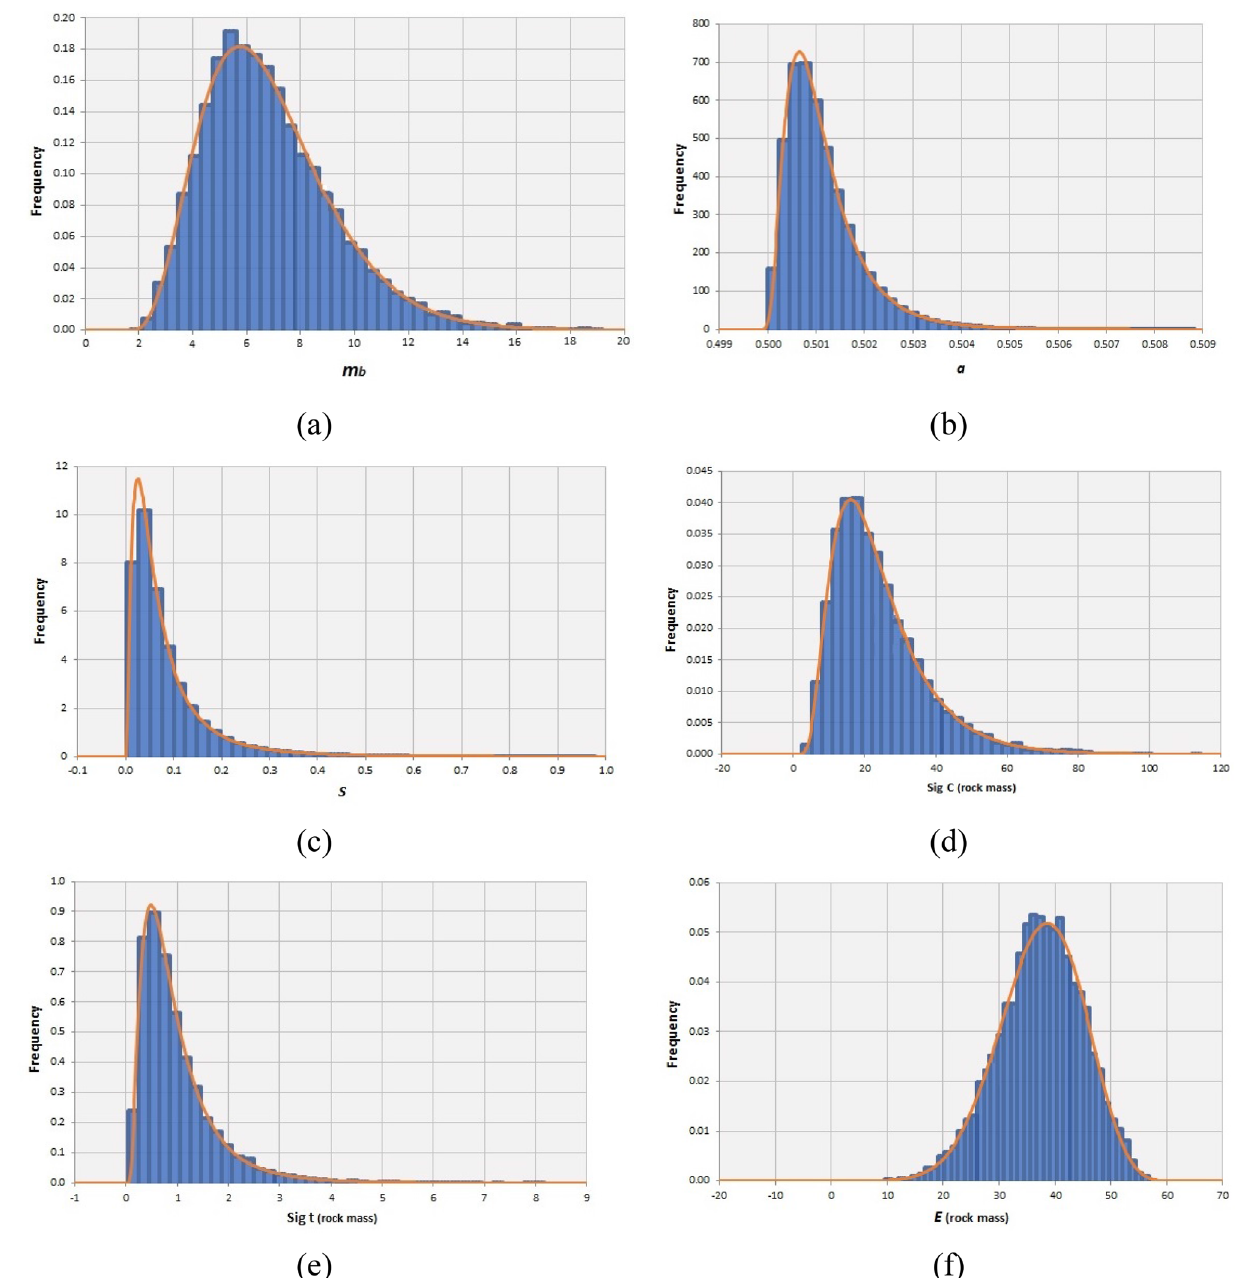
Fig. 9 Histograms and the best-fitted PDF of the geomechanical parameters of the syenite rock